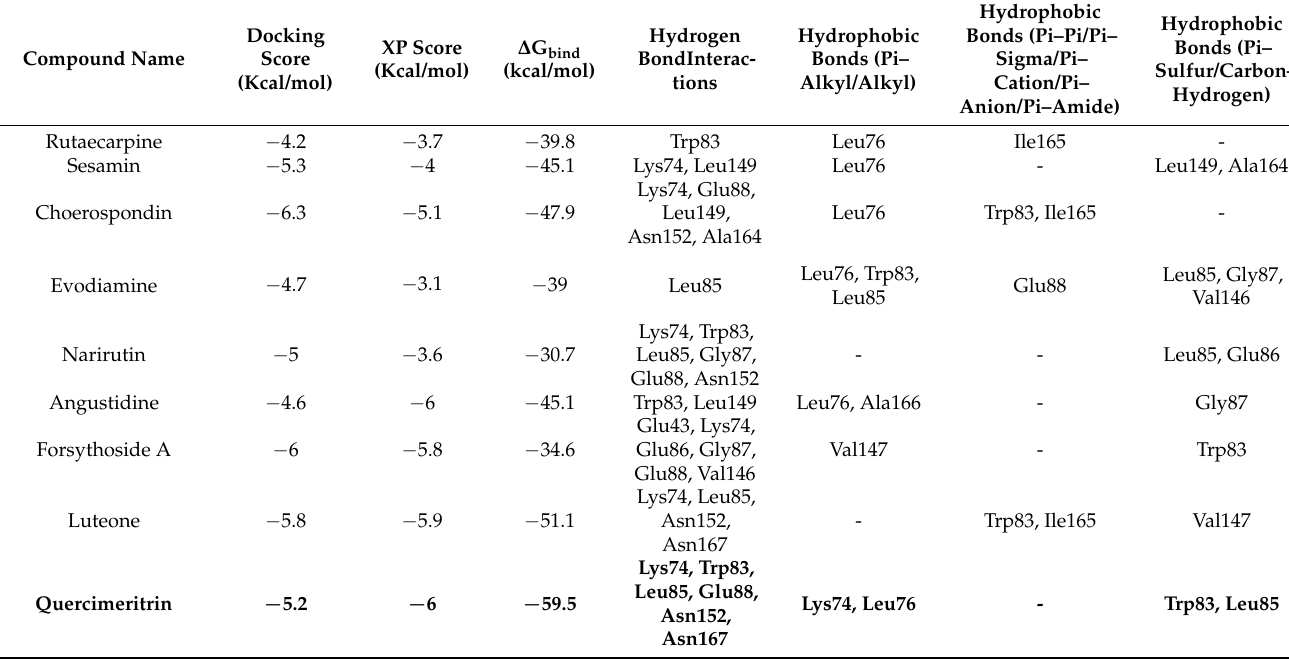
Table 1. The binding energy and interacting residues of the best 27 phytochemicals, the interactions were analyzed in the Discovery Studio and Pymol